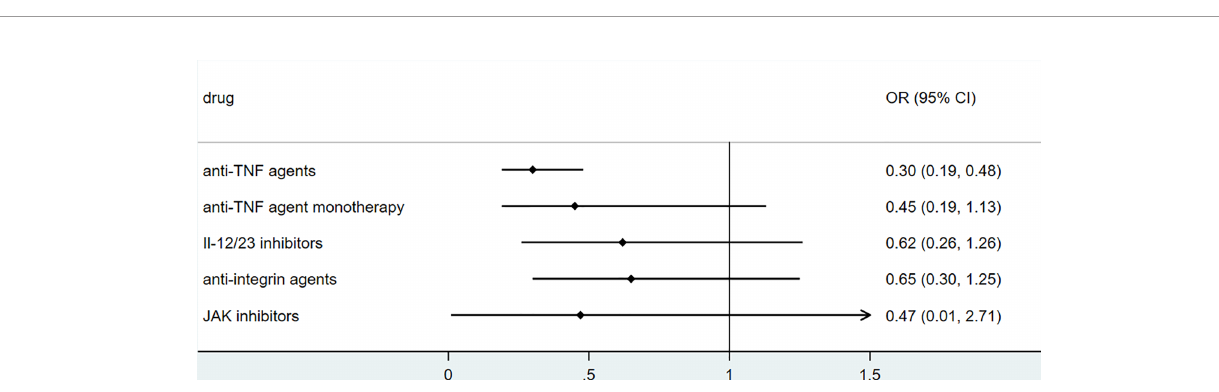
FIGURE 4 | The association of biologics and ventilation rate among IBD patients with COVID-19 according to data from SECURE-IBD (27). [The group ‘ anti-TNF agent monotherapy ’ was compared to the group receiving anti-TNF agent combined with 6MP/AZA/MTX. The other groups ( ‘ Anti-TNF agents ’ , ‘ IL-12/23 inhibitors ’ , ‘ Anti-integrin agents ’ and ‘ JAK inhibitor ’ ) were compared to those did not receive the corresponding